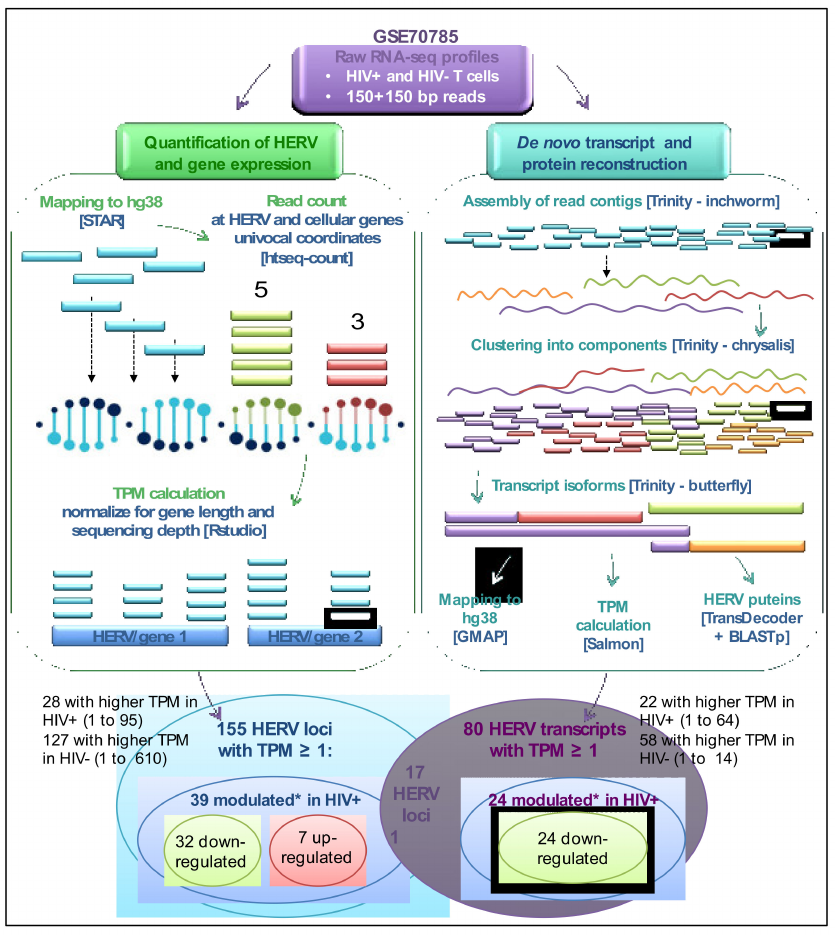
Figure 1. Graphical overview of the bioinformatics pipeline and the identified expressed human endogenous retrovirus (HERV) loci and transcripts. Modulation is based on at least a 3-fold change in the transcripts per million (TPM) value between the two conditions.